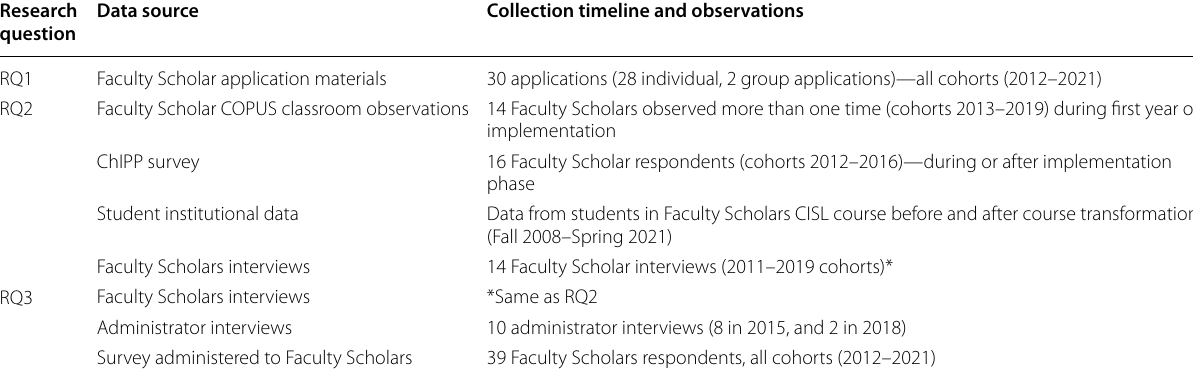
Table 1 Summary of the data collection for each research